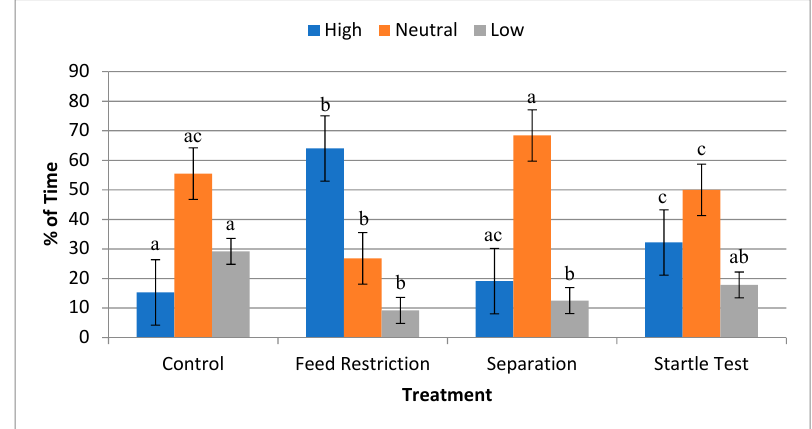
Figure 4. Percentage of time that horses’ ( n = 33) heads were held high, neutral or low (±SD) over a 3 min observation period during feed restriction, separation from conspecifics, a startle test or control. a,b,c differ across treatments p < 0.0001.